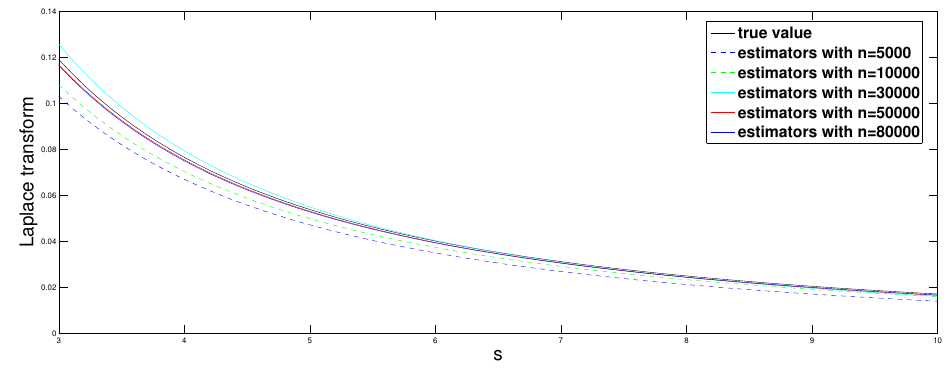
Figure 1. The estimator of L Φ